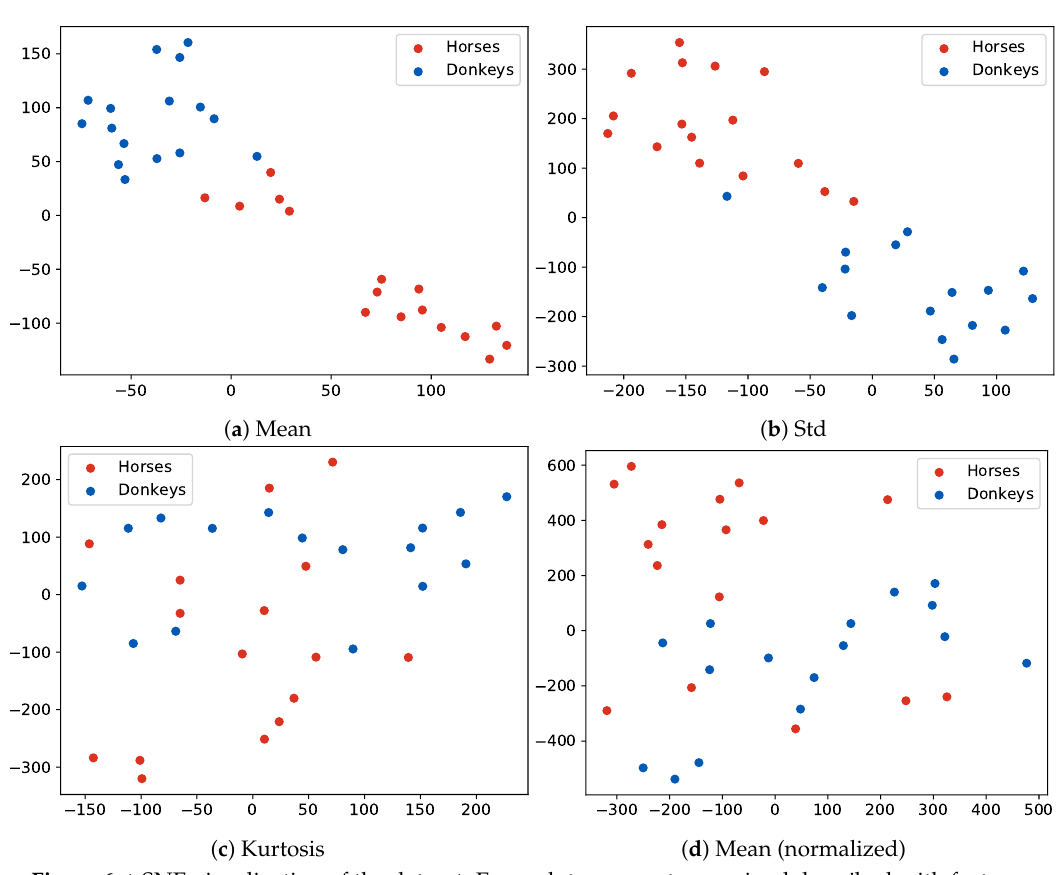
Figure 6. t-SNE visualization of the dataset. Every dot represents an animal described with features extracted from the pixels of its 15 ROIs. Plots present different feature extraction statistics: ( a ) the mean; ( b ) the standard deviation; ( c ) the kurtosis; ( d ) the mean, after removing the global mean temperature of an animal from all pixel values. Notice that the examples in Plot ( a ) form clusters that correspond to the species of the animal, although some examples are in the wrong